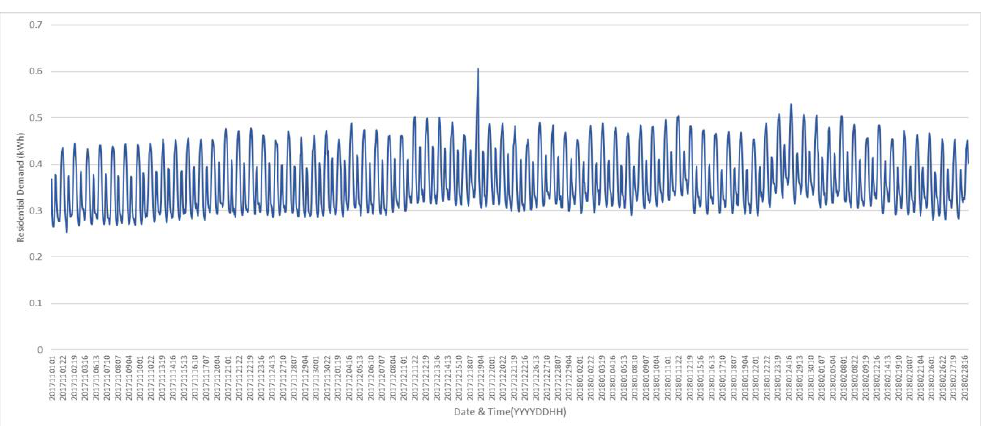
Figure 3. Average hourly demand for residential PTR program customers in Seoul, Korea, from November 2017 through February 2018.